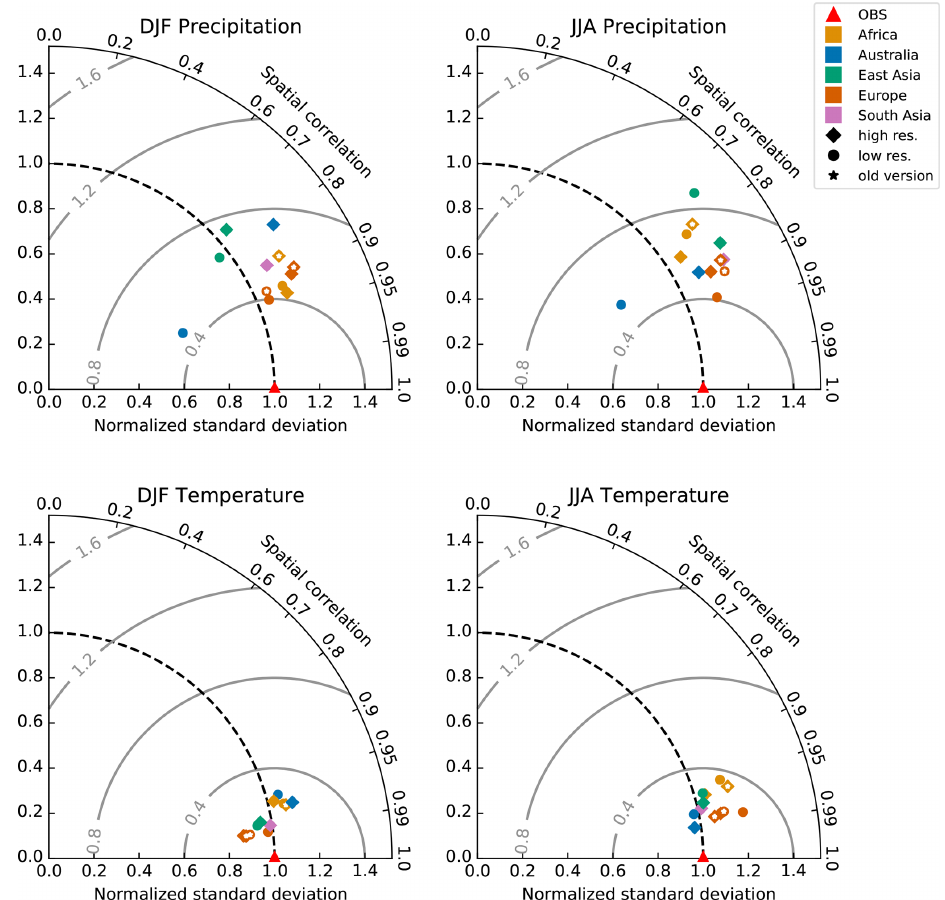
Figure 4. Spatial Taylor diagram exploring the model performance for JJA and DJF for precipitation and 2m air temperature for each domain (labeled with colors) by considering the ERA-Interim-driven simulations. The diamonds (circles) are the 12km or 24km, respectively (50km), simulations. The older model version is marked with a white star inside the symbols. The triangle is the mean of all observations.